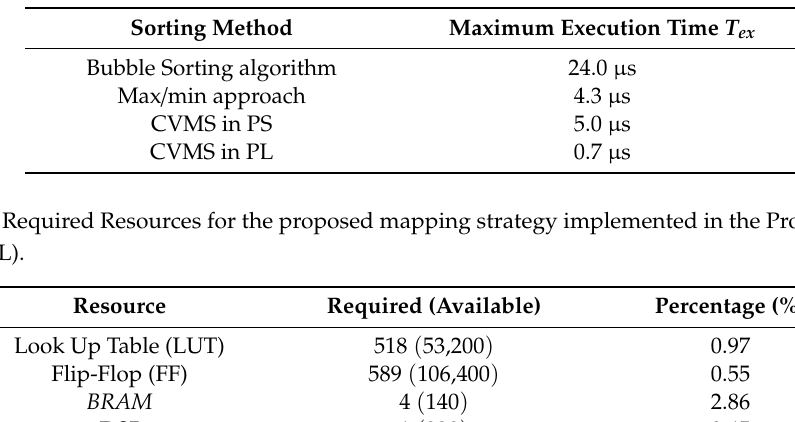
Table 5. Execution time when N = 64.